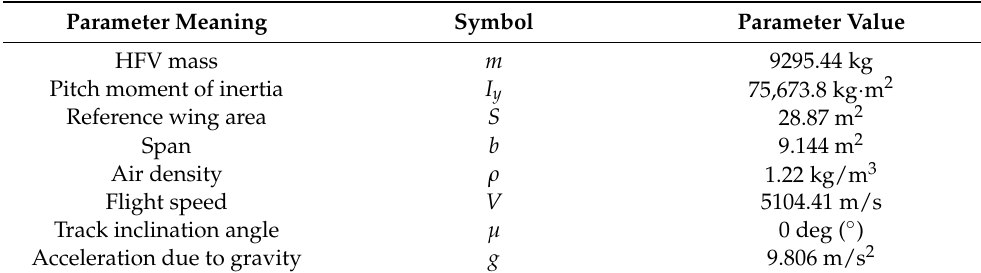
Table 2. HFV simulation control parameters.